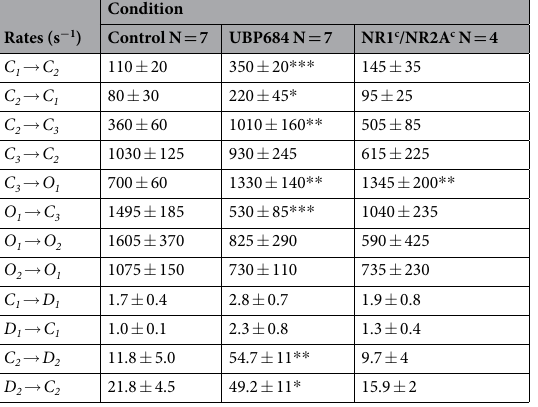
Table 2. Hidden Markov maximum interval likelihood fitting of the steady state currents. Idealized current records were fitted to the gating scheme as described in Fig. 4. All rates have units of s − 1 . Data are mean ± SEM from patches containing one active channel fitted individually. The rates were compared by unpaired t